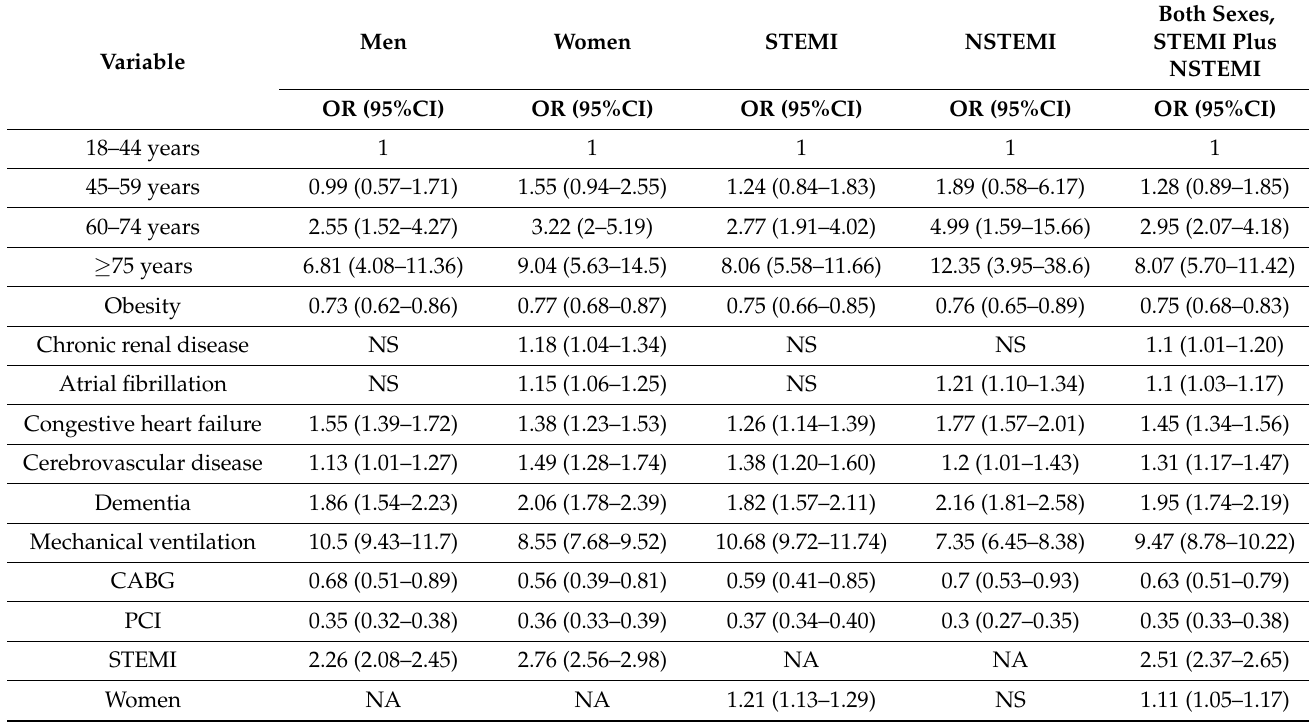
Table 4. Multivariable logistic regression to identify variables independently associated with in-hospital mortality among men and women with an STEMI or NSTEMI and for both sexes according to myocardial infarction type.